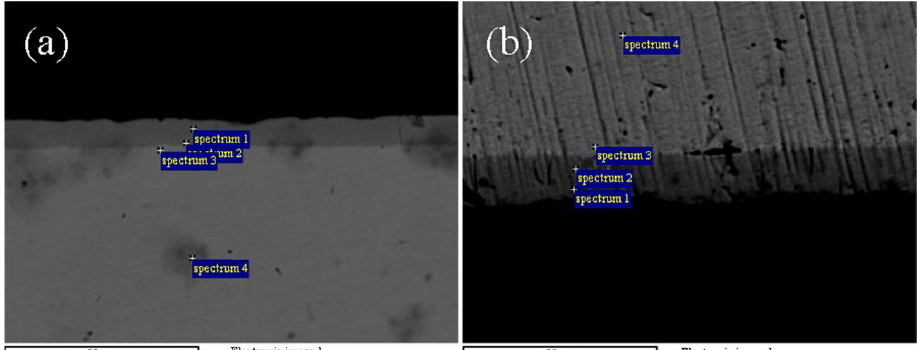
Figure 3. Electron probe microanalysis of chromium carbide and chromium plating coatings. ( a ) Chromium carbide coating; ( b ) Chromium plating coating.